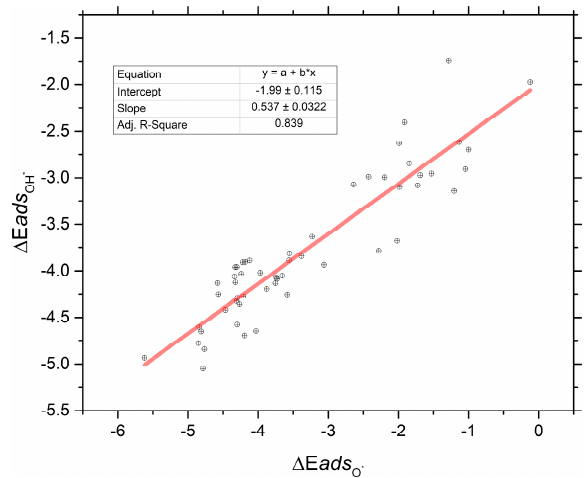
Figure 4. Plot of the correlation of the hydroxyl (OH*) adsorption energy on the MDG NP in this work to that of the corresponding monoatomic oxygen (O*) adsorption energy on the same MDG NP and site(s). The slope, intercept, and R 2 values are reported for the simple linear fit to the data. Energy units for this plot are the same as those in Figures 2 and 3; ev/mol.